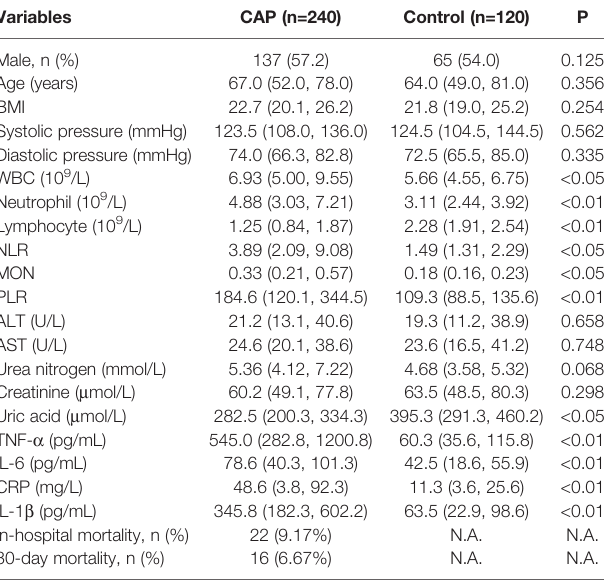
TABLE 1 | Demographic and biochemical characteristics between CAP patients and control subjects.